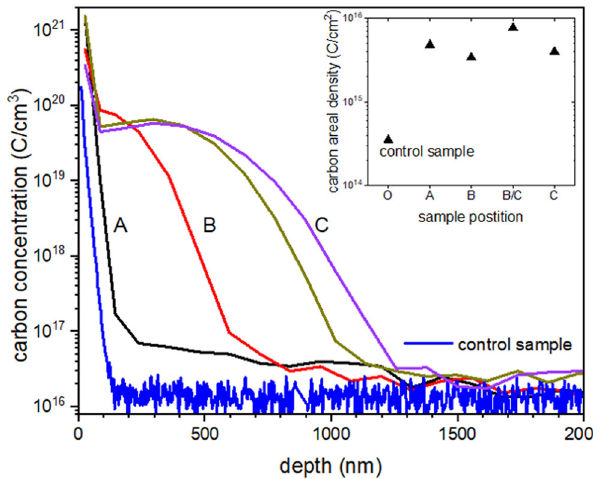
Fig. 7 Secondary ion mass spectrometry (SIMS) depth pro fi les of carbon in a silicon. SIMS depth pro fi les. from a sample that had been exposed to one laser-ion pulse for a series of positions across 1 mm of a sample with positions A, B, C corresponding to I, II, III in Fig. 2. The insert shows the carbon areal densities for the series of positions. A carbon concentration of 10 20 C-atoms cm -3 corresponds to 2000